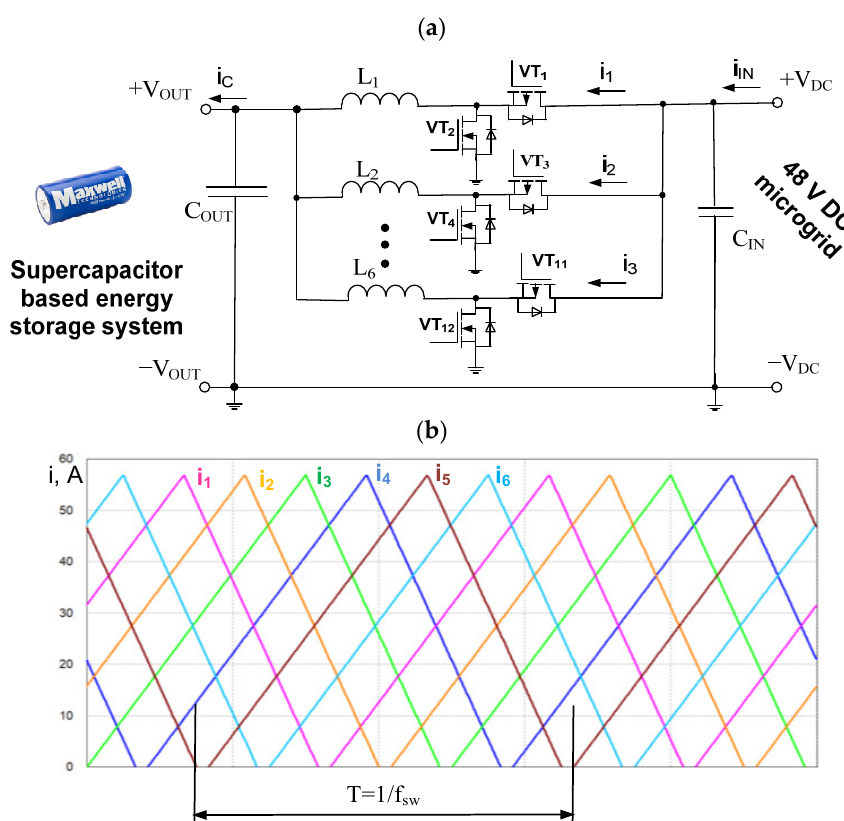
Figure 2. ( a ) Basic schematics of interleaved bidirectional DC–DC converter for supercapacitor energy storage integration into a DC microgrid; ( b ) theoretical waveforms of per-phase